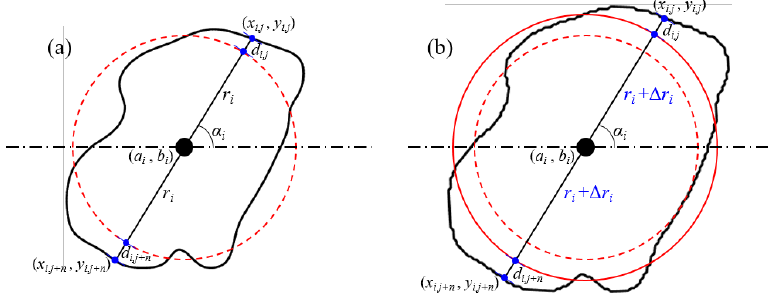
Figure 4. The principle of grain size change. ( a ) Original relationship between grain boundary and mapping circle. ( b ) The relationship between them with the grain radius increasing Δ r i .